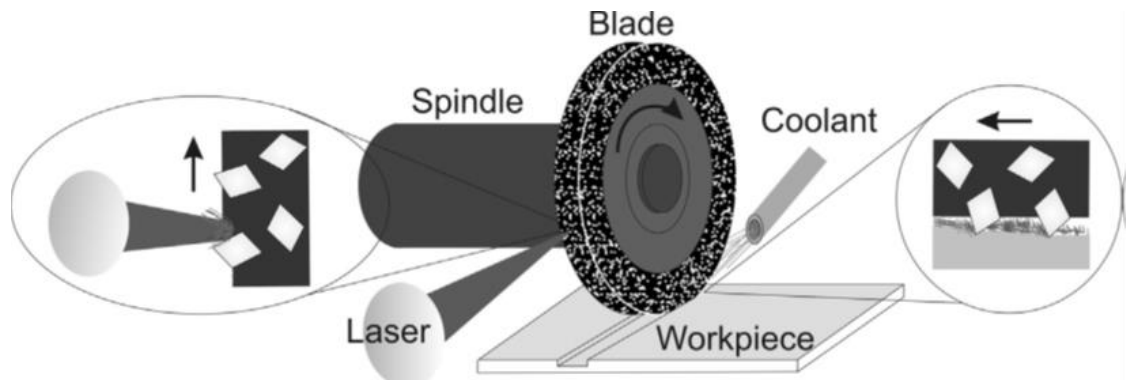
Figure 6. Principle of continuous laser dressing. Adapted with permission from Ref. [30]. 2013, Elsevier.